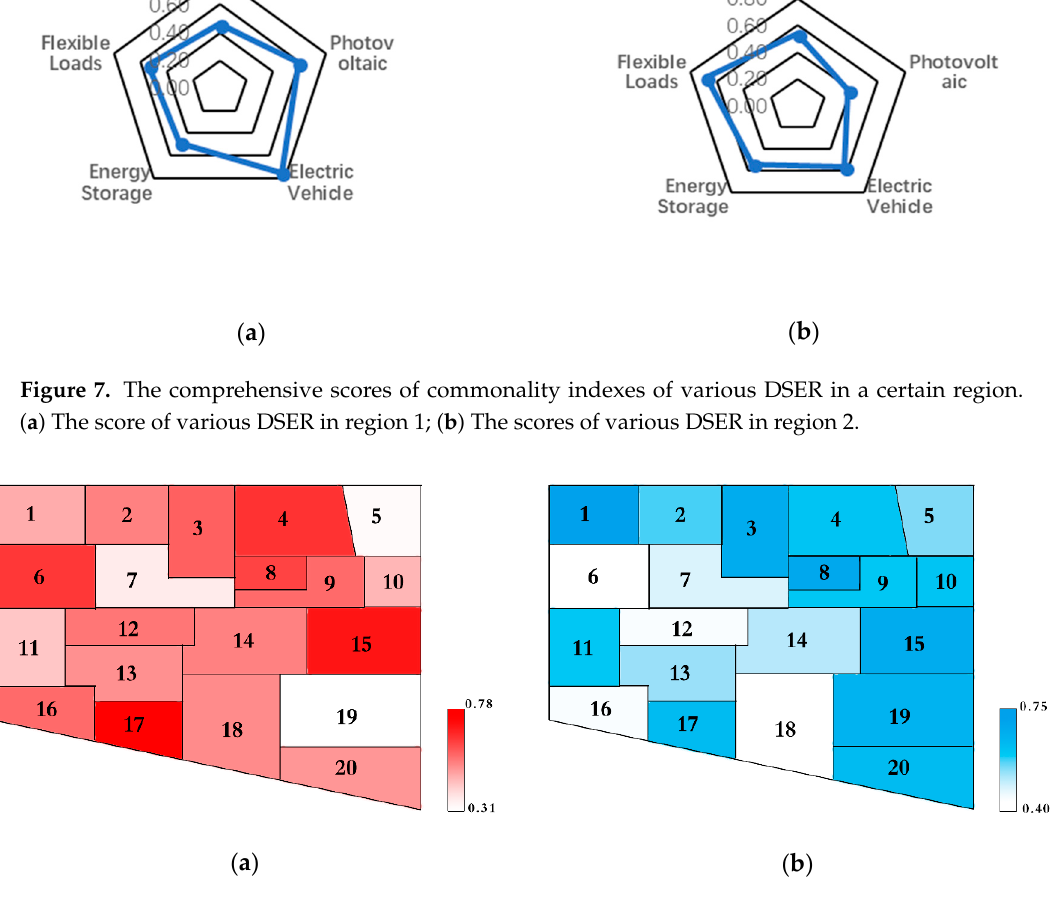
Figure 9. Value of individuality indexes of WG in 20 regions. It can be seen from Figure 9 that among the 20 regions, the number of system failures of WG in region 5 is the lowest, but the remaining indexes are in a backward position in the ranking. The daily peak rate and daily load fluctuation rate of WG in region 9 are relatively good, but the system has more failures. 5.2.2. The Calculation of Weights of Individuality Indexes The entropy weight method is used to calculate the weights of the individuality indexes upon various DSER according to Equations (8) to (11), as shown in Figure 10.